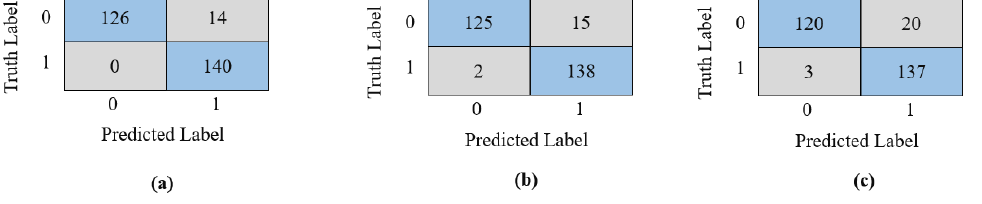
Figure 11. Confusion matrix of model ( a ) Xception ( b ) ResNet50V2 ( c ) MobileNetV2 on second test